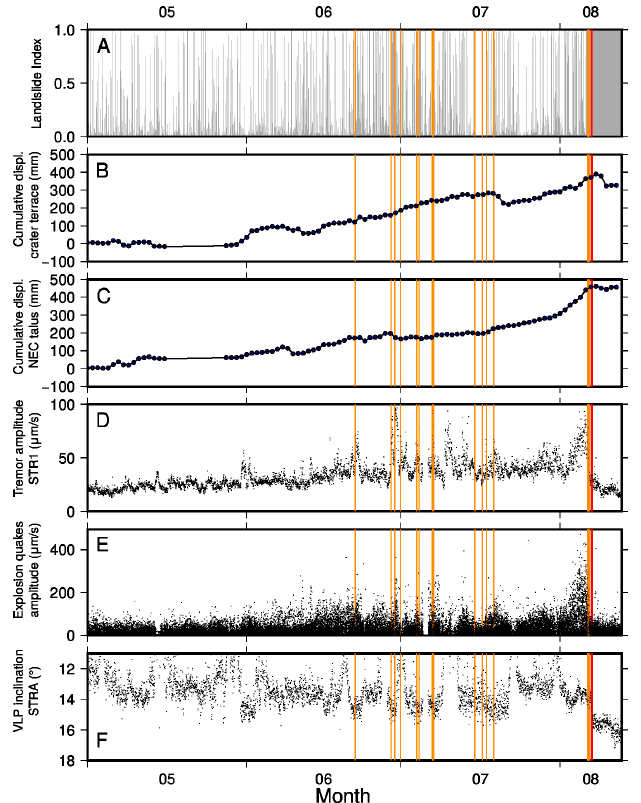
Figure 3. Relevant geophysical time-series from May to August 2014. ( A ) Landslide index derived from seismic data; GBInSAR cumulative displacement data for ( B ) the crater terrace and ( C ) for the NEC-talus. ( D ) Volcanic tremor amplitude at station STR1. ( E ) Explosion-quake amplitudes at station STR1. ( F ) VLP polarization inclination at station STRA.